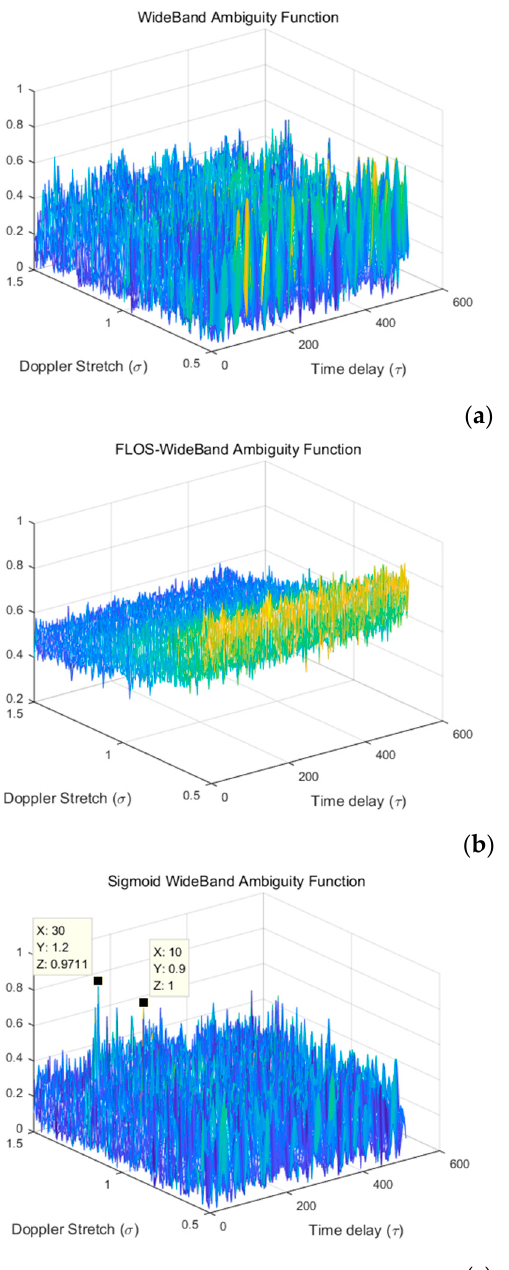
Figure 4. The normalized spectra of WBAF, FLOS-WBAF, and Sigmoid-WBAF for impulsive noise = =α and 2.1 . ( a ) The 3D plot of WBAF and its DS and TD section planes; ( b ) with GSNR 2dB the 3D plot of FLOS-WBAF with p = 1.1 and its DS and TD section planes; ( c ) the 3D plot of FLOS- WBAF with p = 1.4 and its DS and TD section planes; ( d ) the 3D plot of Sigmoid-WBAF and its DS and TD section planes.